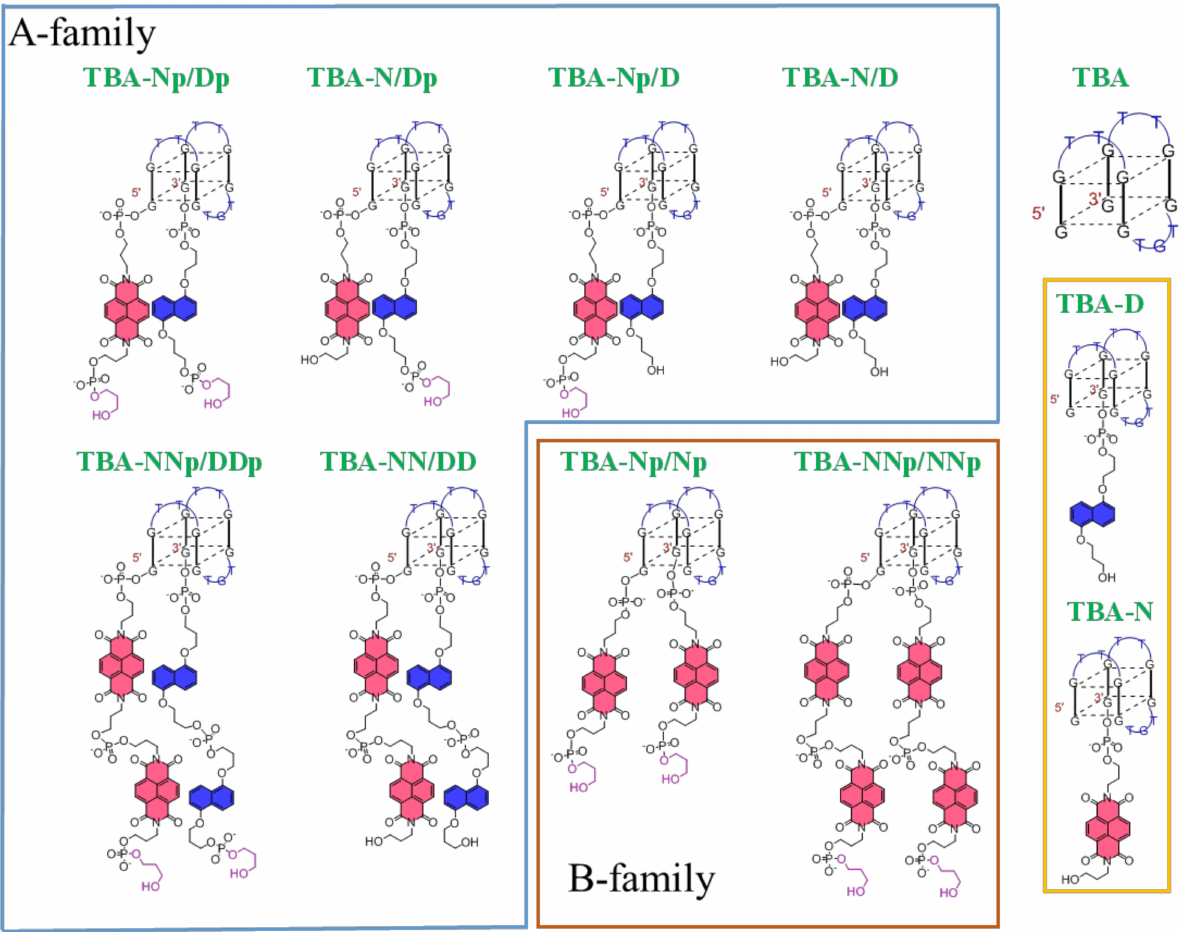
Figure 1. Chemical structures of the oligonucleotides investigated herein. N = naphthalene diimide; D = dialkoxy naphthalene; p = 1,3-propanediol